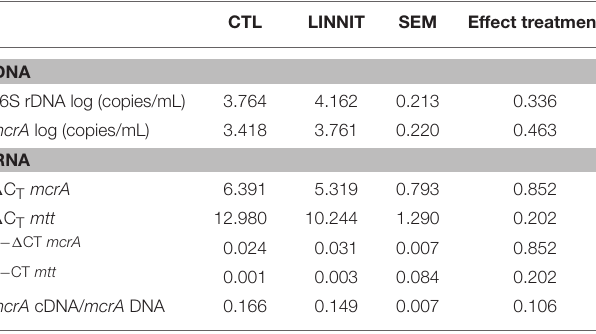
TABLE 3 | qPCR quantification of 16S rDNA and mcrA copy numbers and mcrA and mtt expression analysis in rumen contents. CTL LINNIT